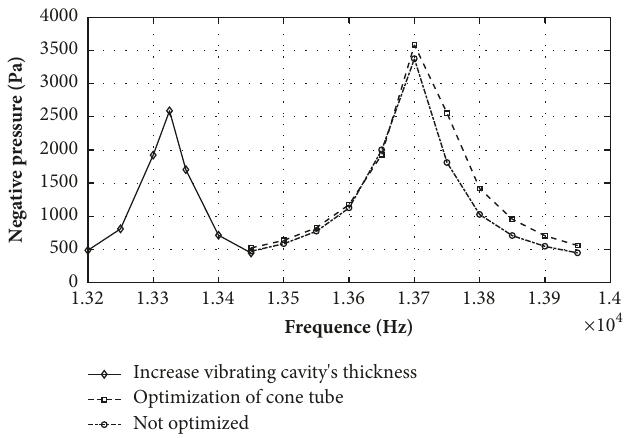
Figure 18: Negative pressure’s frequency response